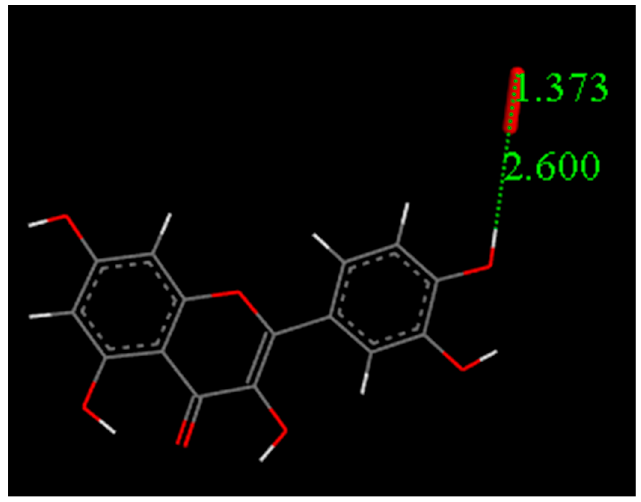
Figure 15. DFT Initial State for scavenging superoxide radical by quercetin. Both reagents are separated by van der Waals parameters, 2.60 Å. Antioxidants 2018 , 7 , x FOR PEER REVIEW